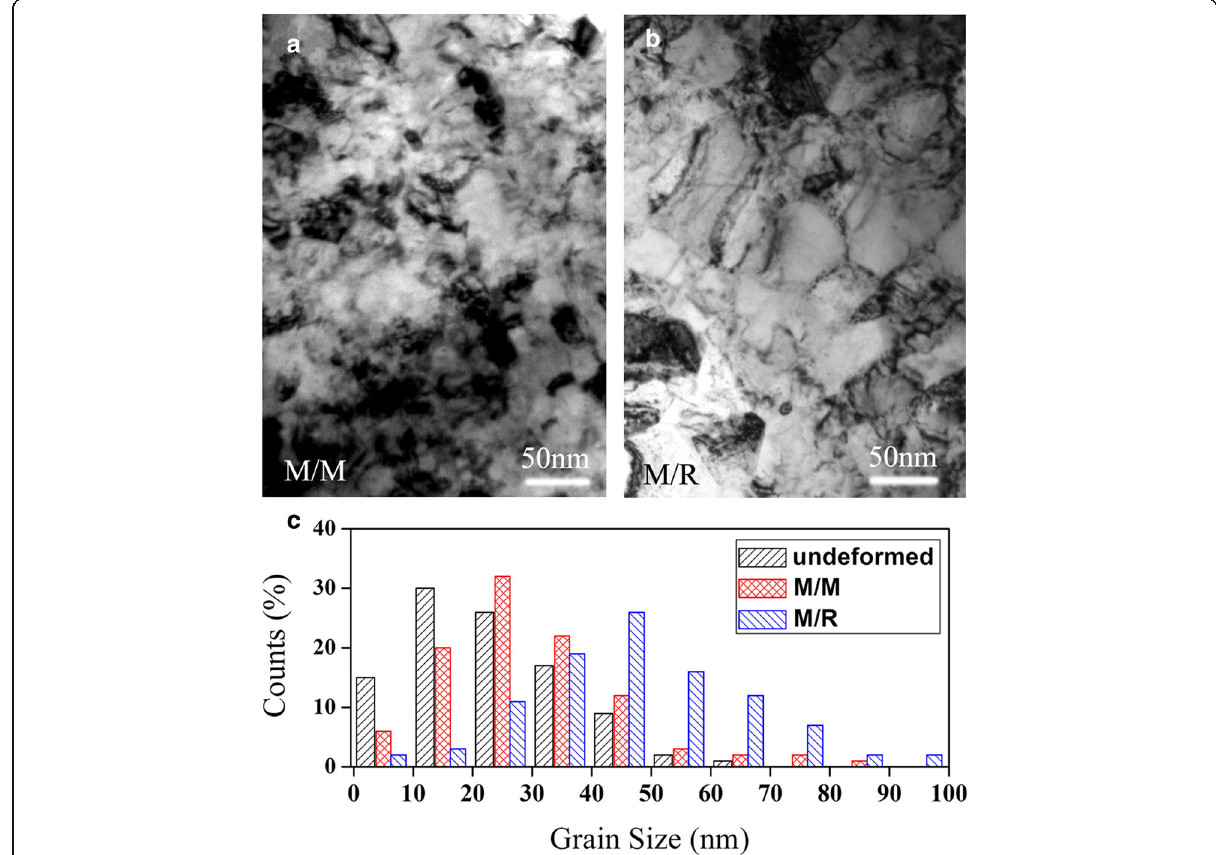
Fig. 3 Typical TEM images of a the metal/metal (M/M) contact interface and b the metal/roll (M/R) contact interface after the final pack rolling pass. The grain size distribution before and after deformation is shown in